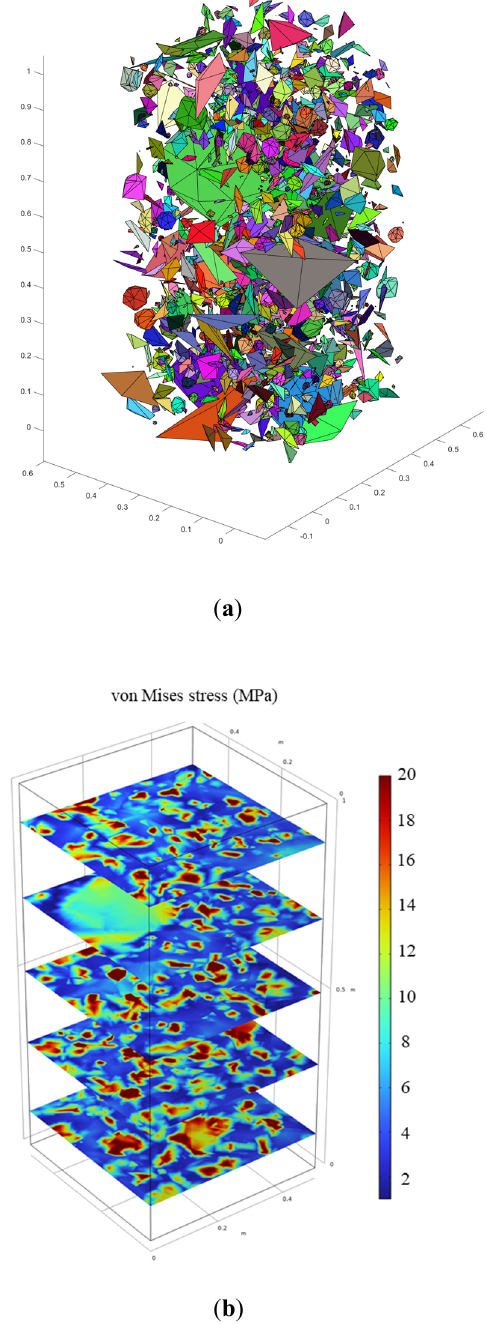
Figure 10. Examples of numerical simulation based on the proposed algorithm: ( a ) generated mesostructure; ( b ) von Mises stress under a uniaxial pressure.